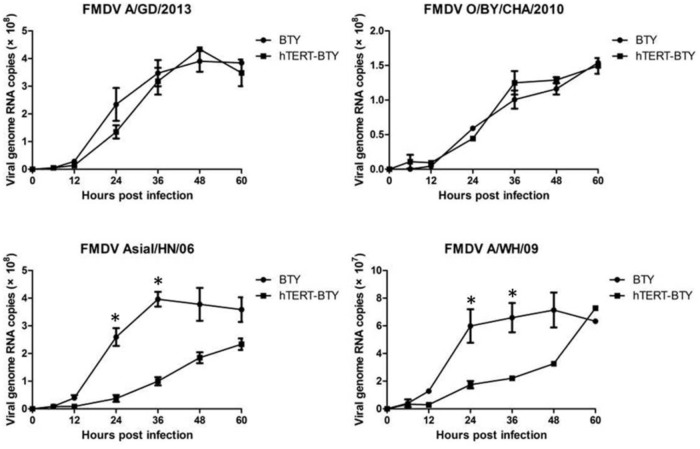
Viral genome RNA replication dynamics. hTERT-BTY cells (5 × 105 cells/well) were infected with the indicated four viruses at a dose of 1 × 106 viral genome RNA copies for 1 h, and unabsorbed viruses were washed. Cells and supernatants were harvested 0, 6, 12, 24, 36, 48, and 60 h after the infection, and the expression of viral RNA was determined using RT-PCR. Experiments were performed in triplicate and repeated three times with similar results. Data are represented as mean ± SD (n = 3). Statistical significance was analyzed by Student’s t-test: ∗P < 0.05, ∗∗P < 0.01.